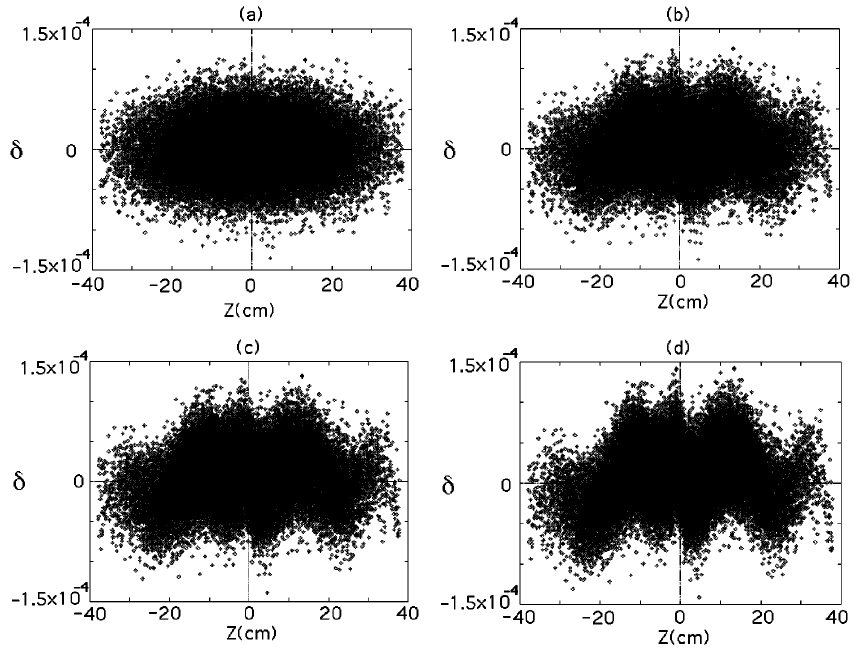
k k j . j (cid:90) j in (a)–(d) are 0.1, 0.5, 0.7, and (cid:49) V , (cid:48) (cid:48) (cid:110) (cid:110) jj j to compensate (cid:48) (cid:110) (cid:104)